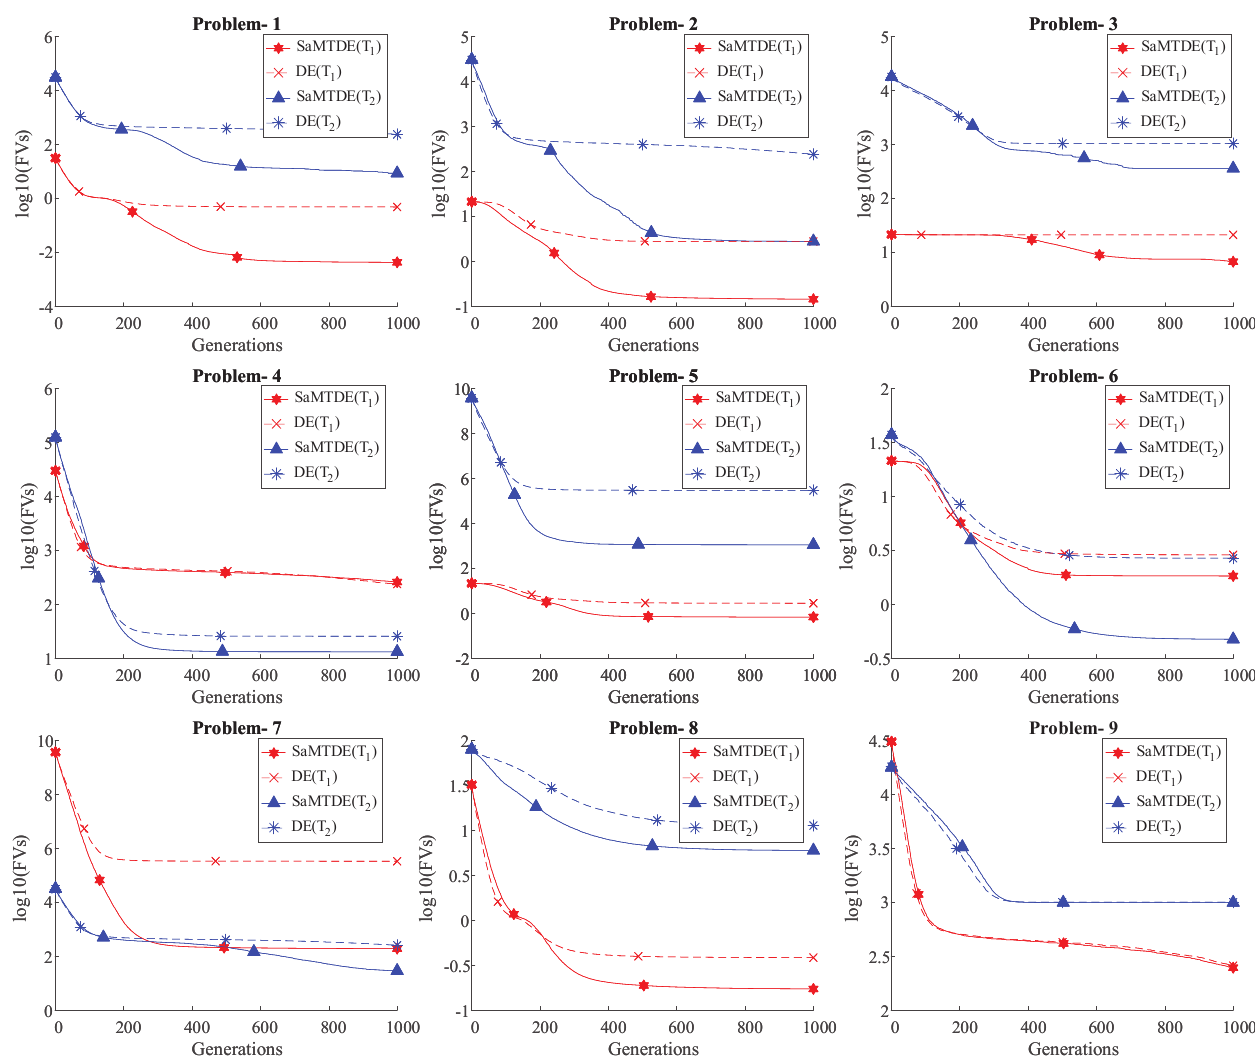
Figure 3. Averaged convergence curves of DEMTO versus the DEMTO_STO on the 9 test problems from CEC’2017 Evolutionary Multi-Task Optimization